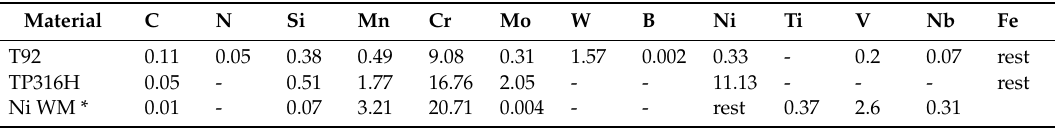
Table 1. Chemical composition (wt%) of base materials and Ni-based weld metal (Ni WM) of T92 / TP316H dissimilar